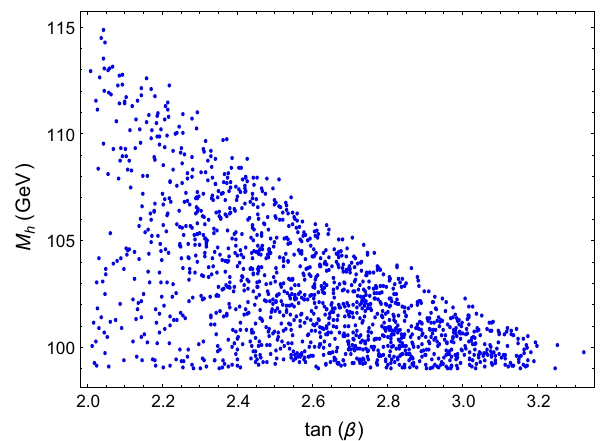
Fig. 1 TreelevelcontributiontotheHiggs-likebosonmassasfunction of tan (β)